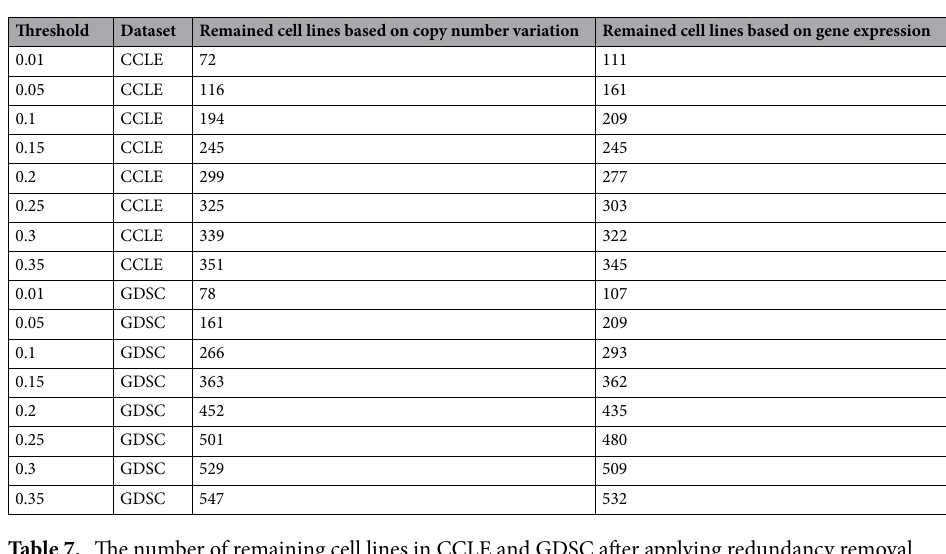
Table 7. The number of remaining cell lines in CCLE and GDSC after applying redundancy removal procedure with different levels of strictness (threshold) based on copy number variation and gene expression.